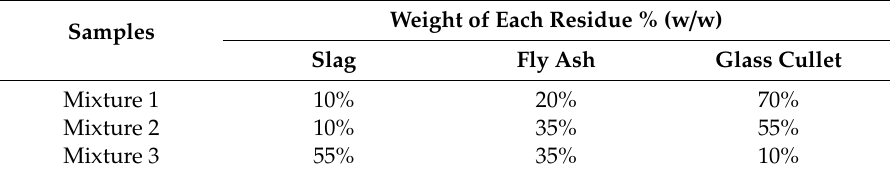
Table 1. Specific mixtures of the produced glass-ceramic materials.